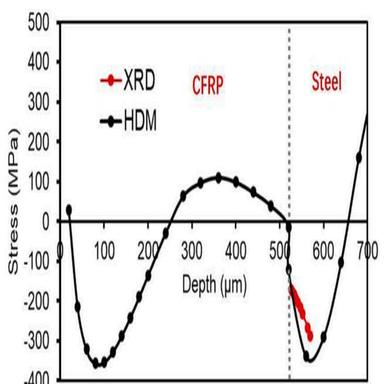
Comparison of residual stresses in CFRP/Steel/CFRP experimentally determined by ED-XRD and IHD.